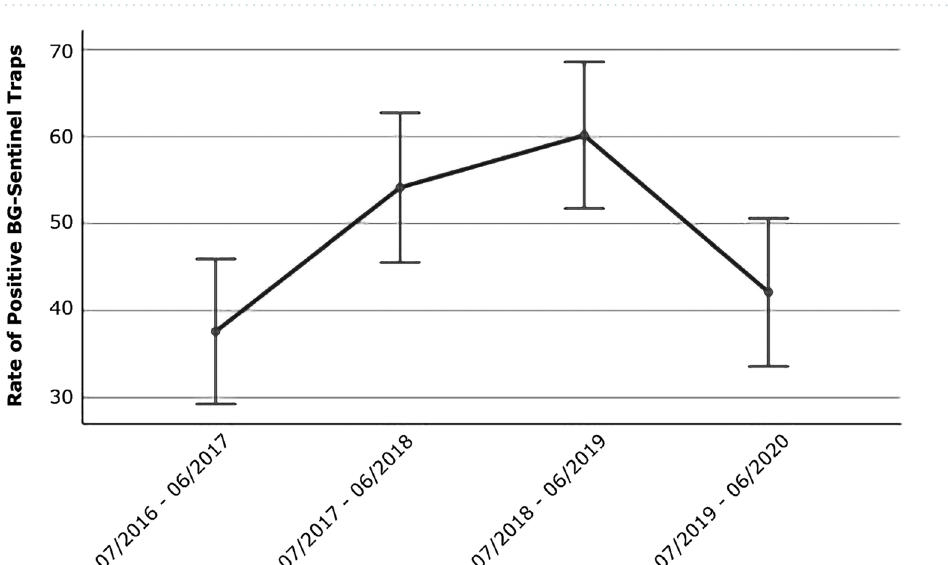
Figure 3. Graph of means of positive BG-Sentinel traps for species from the Culex coronator complex collected from July 2016 to June 2020 in Miami-Dade County, Florida. Each point displays the mean value; the whisker interval represents a 95% confidence interval standard error; the Quadratic effect was significant with a P value of <